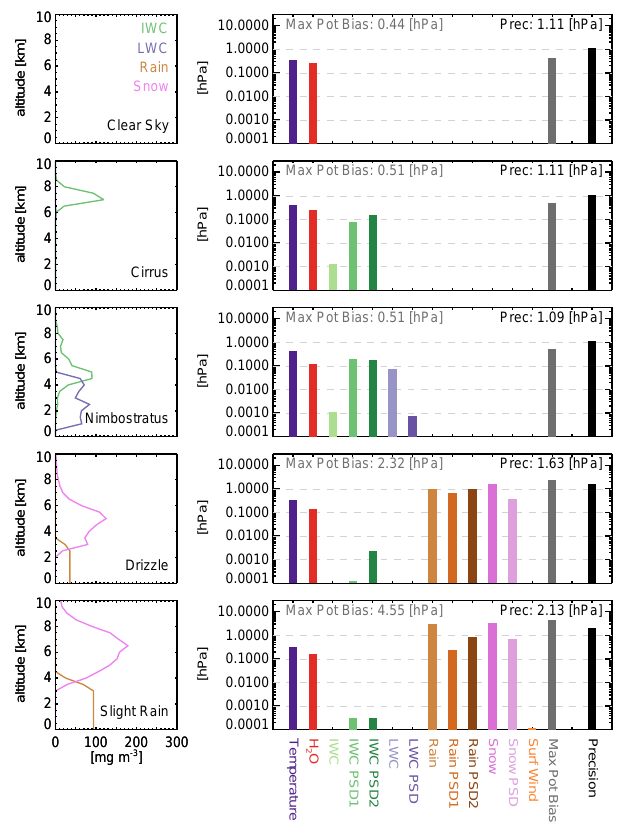
Figure 8. As Fig. 6 except these simulations were performed using the radar tones listed in Table